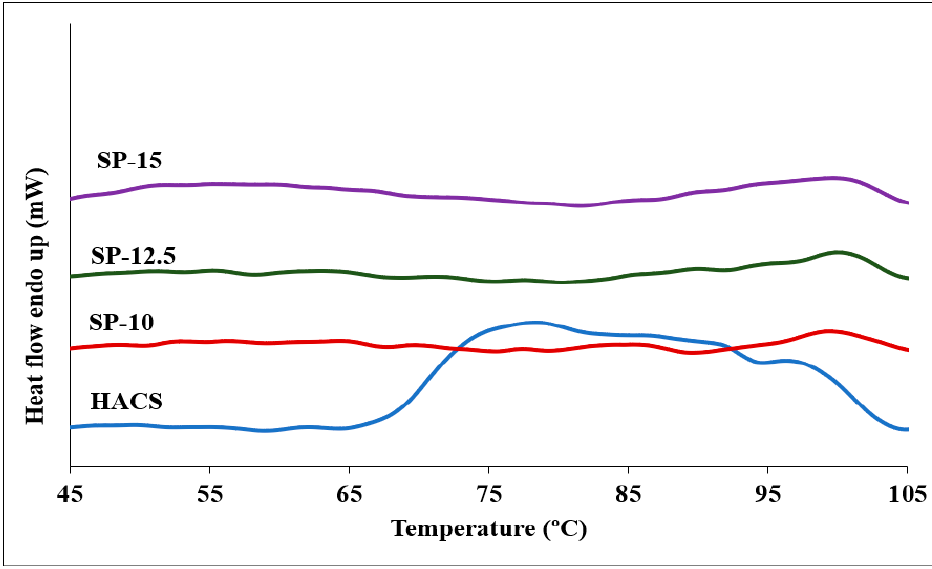
Figure 8. DSC profiles of the HACS and 3D-printed starch beads generated using starch concentrations of 10, 12.5, and 15% ( w / w